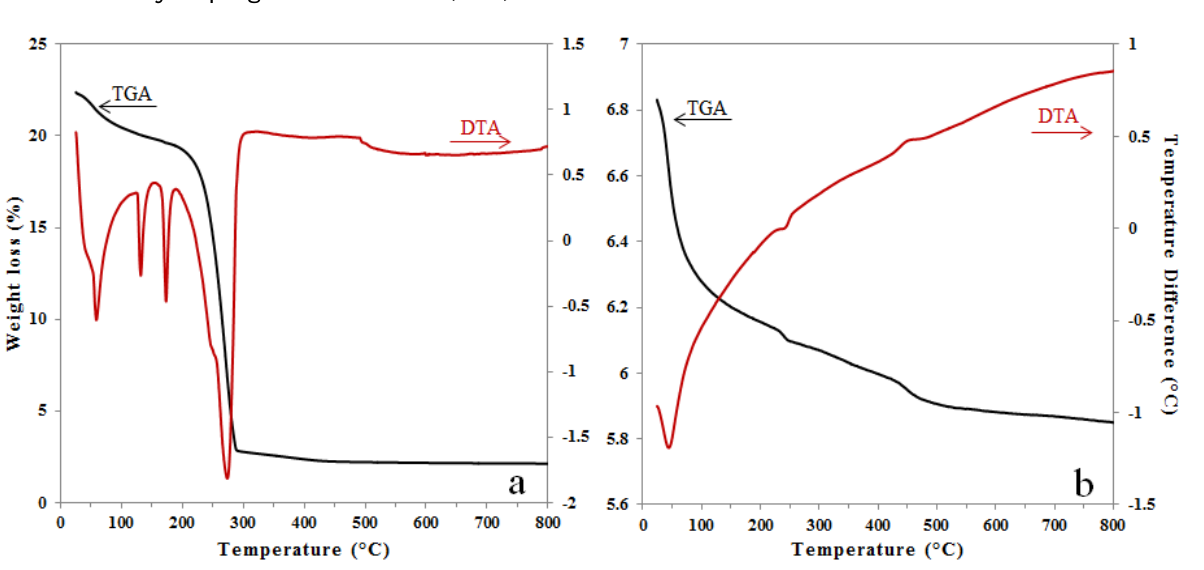
Figure 1. Thermogravimetric analysis (TGA) and differential thermal analysis (DTA) of ( a ) alumina doped with Fe in situ using the sol-gel method (AFSG) and ( b ) alumina doped with Fe by impregnation method